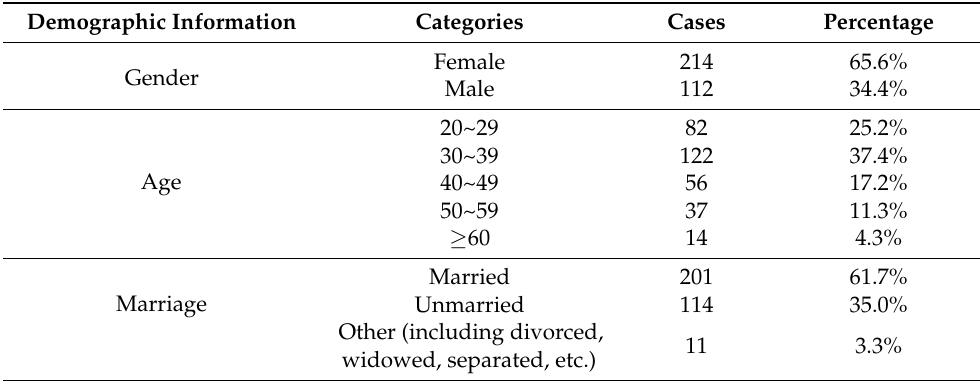
Table 1. Demographic information of